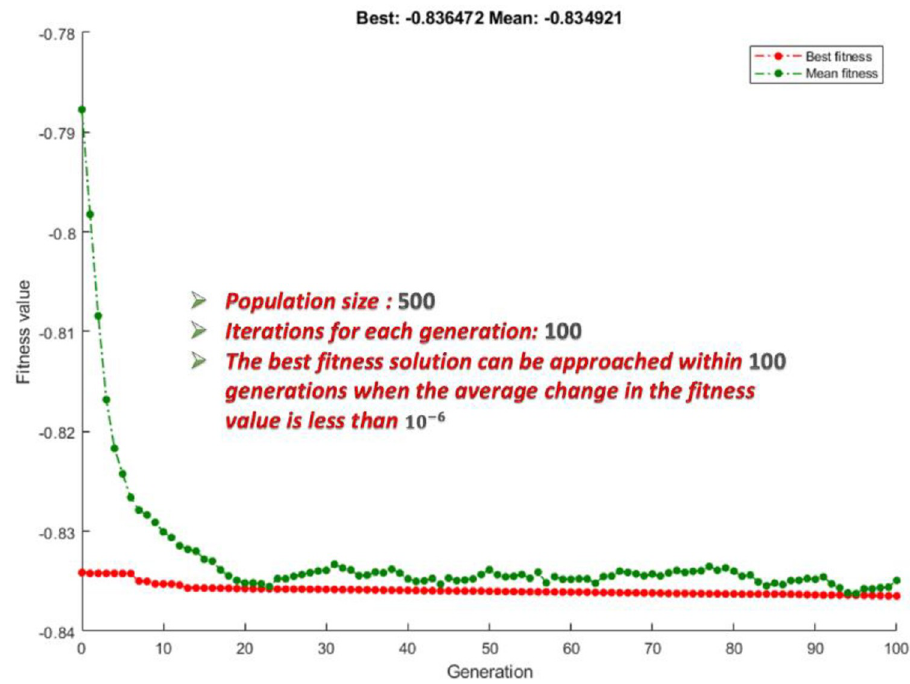
Fig 7. The convergence plot of GA for the equal weights’ scenario ( w i = 0.25) and DC priority. In general, the value for the best fitness can be attained within 100 generations.